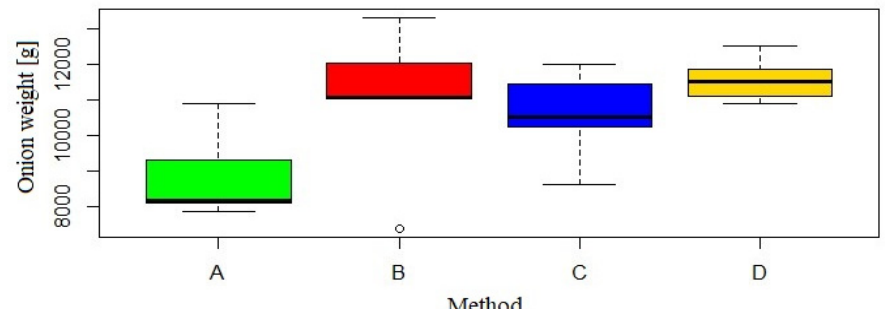
Figure 13. Weight of onions harvested form the plots, which is the productive yield (fractions 40 −